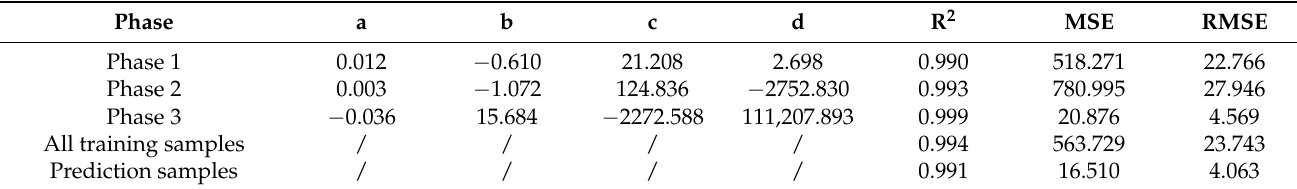
Table 7. Parameters of the trend term of displacement based on polynomial fitting.